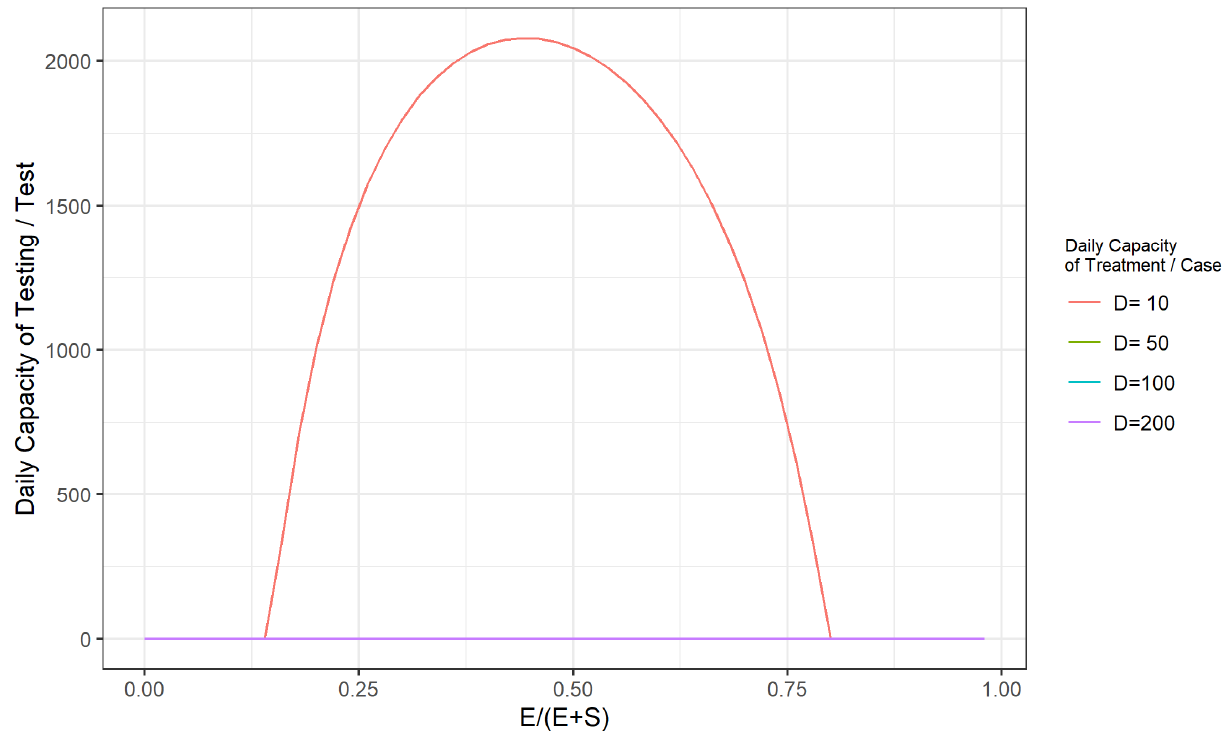
Figure A15. Relationship between the daily testing capacity of the epidemic and the potential level of the epidemic development ( S + E = 8000, I = 1000).